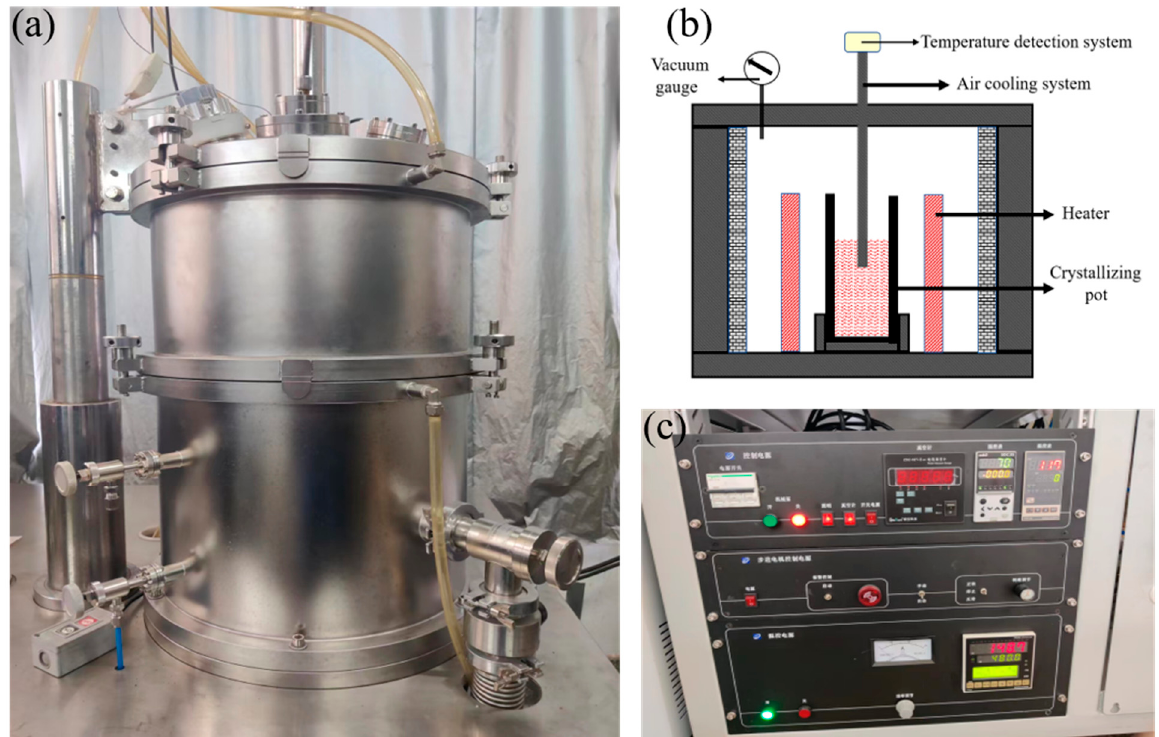
Figure 1. Diagram of rotating crystallizer: ( a ) photograph of the rotating crystallizer; ( b ) structural schematic diagram of the rotating crystallizer; ( c ); temperature control system of the rotating crystallizer.